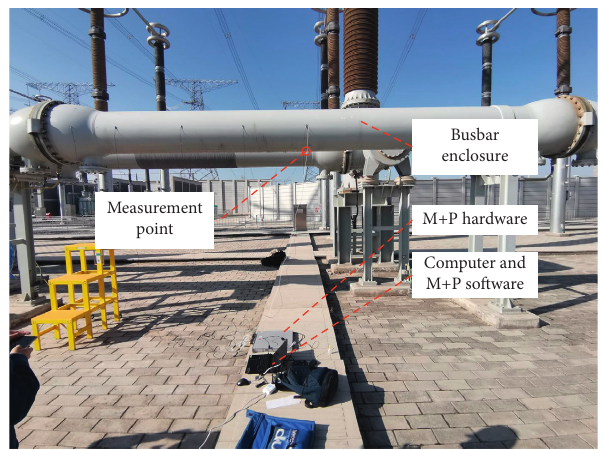
Figure 15: The equipment in the vibration test.